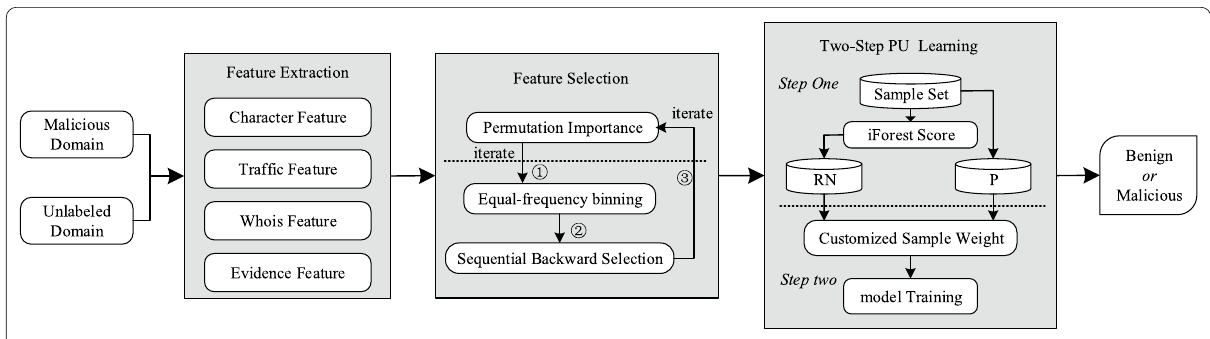
Fig. 1 High-level overview of